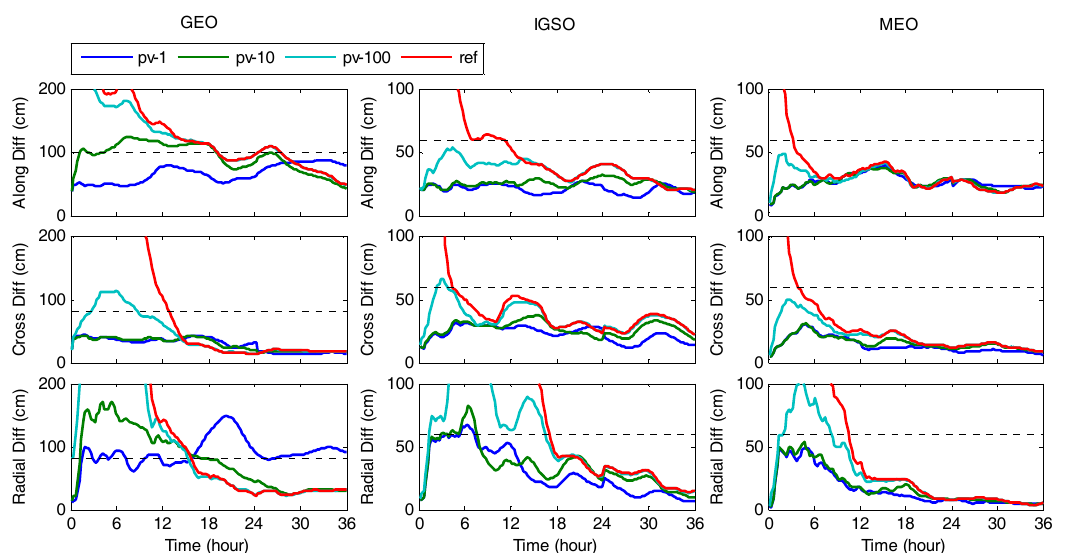
Figure 5. Time series of the average orbit accuracy using different a priori STD of PV parameters. The UR product is used as the initial orbit and the latency time is 3 h. The horizontal black dotted line represents the convergence criteria for each direction. Table 7. Optimal a prior STD magnitude of SRP and PV parameters when the UR product is used as the initial orbit.